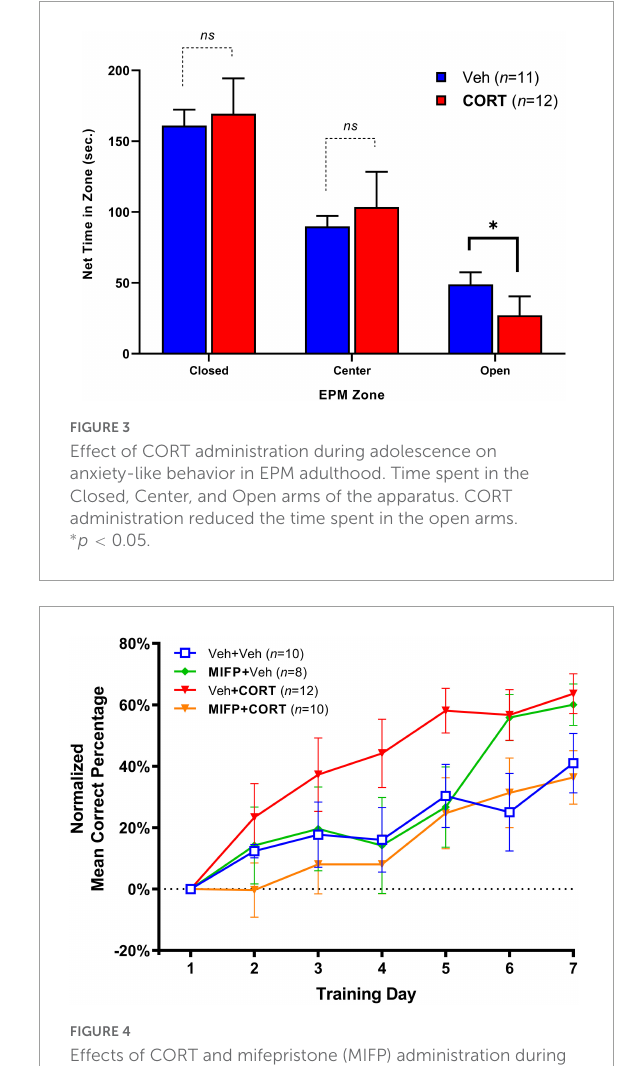
FIGURE4 Effects of CORT and mifepristone (MIFP) administration during adolescence on response learning in adulthood (Mean Percent Correct ± SEM). CORT administration enhanced task acquisition and this effect was blocked by concurrent